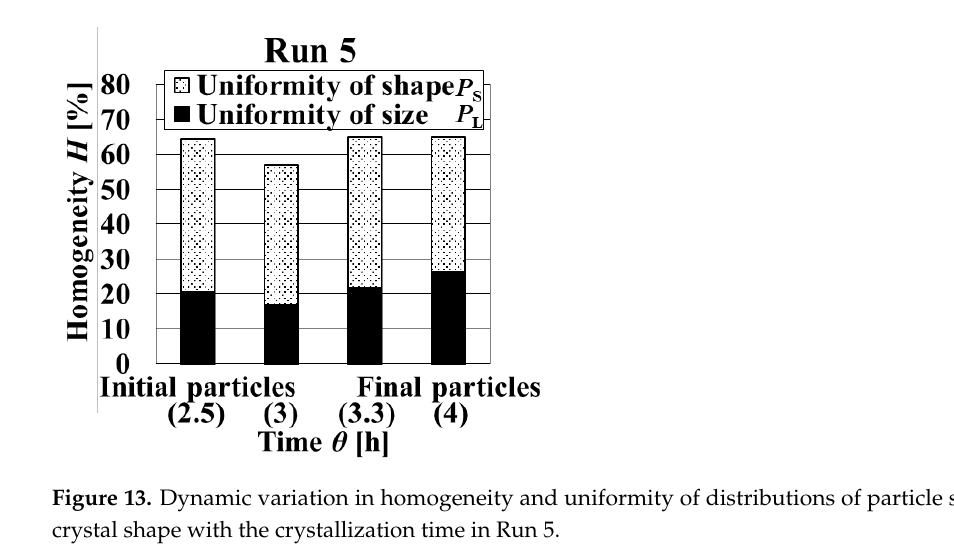
Figure 12. SEM photomicrograph of crystalline particles obtained in Run 5. ( a ) Initial particles. ( b ) Final particles. ( b’ ) High-magnification image of the final particles.